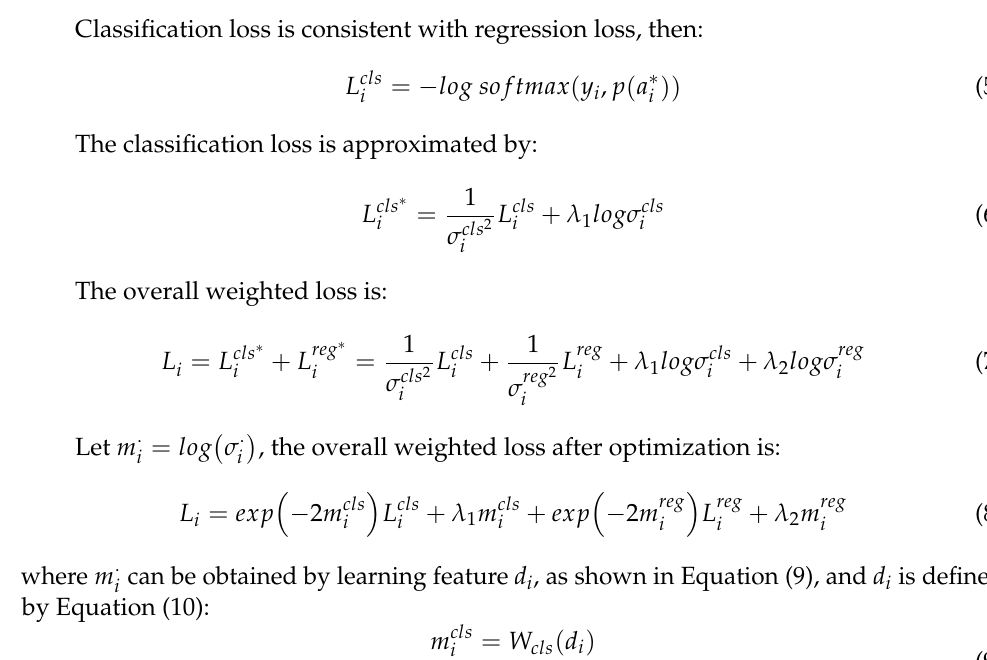
Figure 7. Sample Weighted Loss Function Module Architecture. ( a ) is overall weighted loss. ( b ) is generated sample weights.